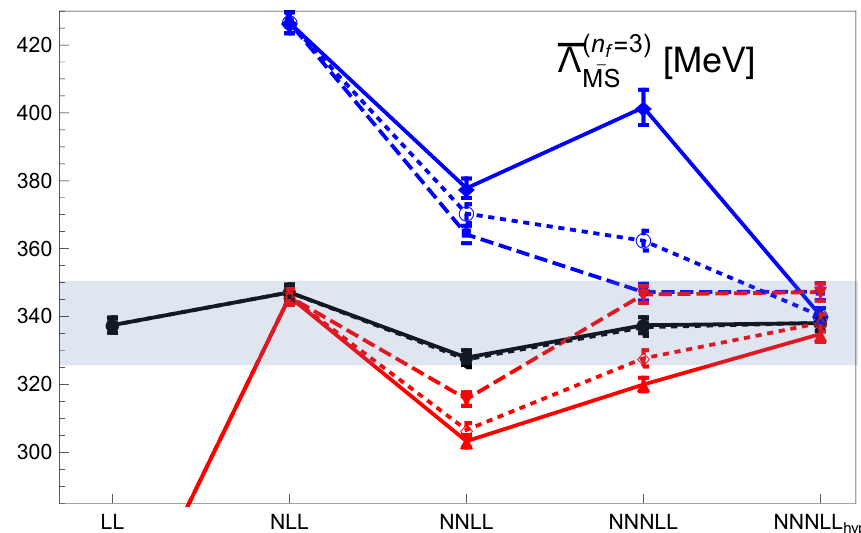
Figure 5 . Determination of (cid:3) ( n f =3) at LL, NLL, NNLL, NNNLL and NNNLL hyp using the data MS set I with di(cid:11)erent options for the (soft, ultrasoft) scale: A) with ( (cid:23) s ; (cid:23) us ) = (1 =r; C A (cid:11) ( (cid:23) s ) = (2 r )) (continuous black line with (cid:12)lled black points), with ( (cid:23) s ; (cid:23) us ) = (2 =r; C A (cid:11) ( (cid:23) s ) = (2 r )) (continuous p blue line with (cid:12)lled blue diamonds), and with ( (cid:23) s ; (cid:23) us ) = (1 = ( 2 r ) ; C A (cid:11) ( (cid:23) s ) = (2 r )) (continuous red line with (cid:12)lled red triangles); B) with ( (cid:23) s ; (cid:23) us ) = (2 =r; 2 C A (cid:11) ( (cid:23) s ) = (2 r )) (dashed blue line with p p (cid:12)lled blue squares), and with ( (cid:23) s ; (cid:23) us ) = (1 = ( 2 r ) ; C A (cid:11) ( (cid:23) s ) = (2 2 r )) (dashed red line with (cid:12)lled red inverted triangles); and C) with ( (cid:23) s ; (cid:23) us ) = (1 =r; 1 GeV) (dotted black line with empty black points), with ( (cid:23) s ; (cid:23) us ) = (2 =r; 1 GeV) (dotted blue line with empty blue points), and with ( (cid:23) s ; (cid:23) us ) = p (1 = ( 2 r ) ; 1 GeV) (dotted red line with empty red diamonds). The error displayed is only